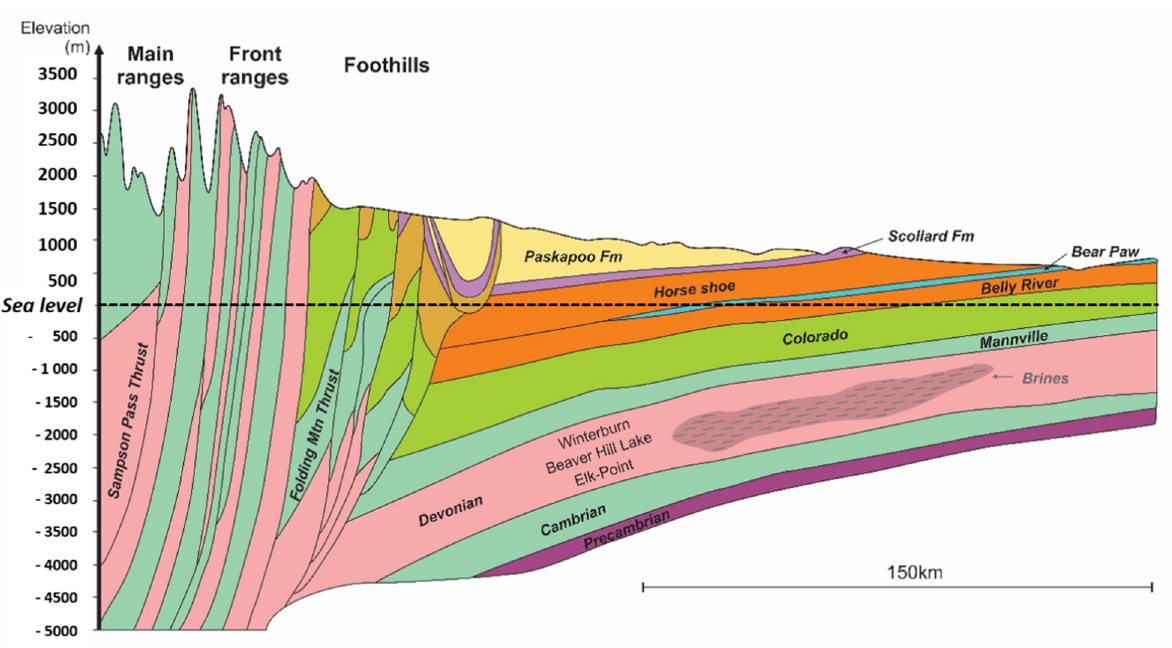
Figure 3. Conceptual Model of the geological setting; modified from [22] (vertical exaggeration =